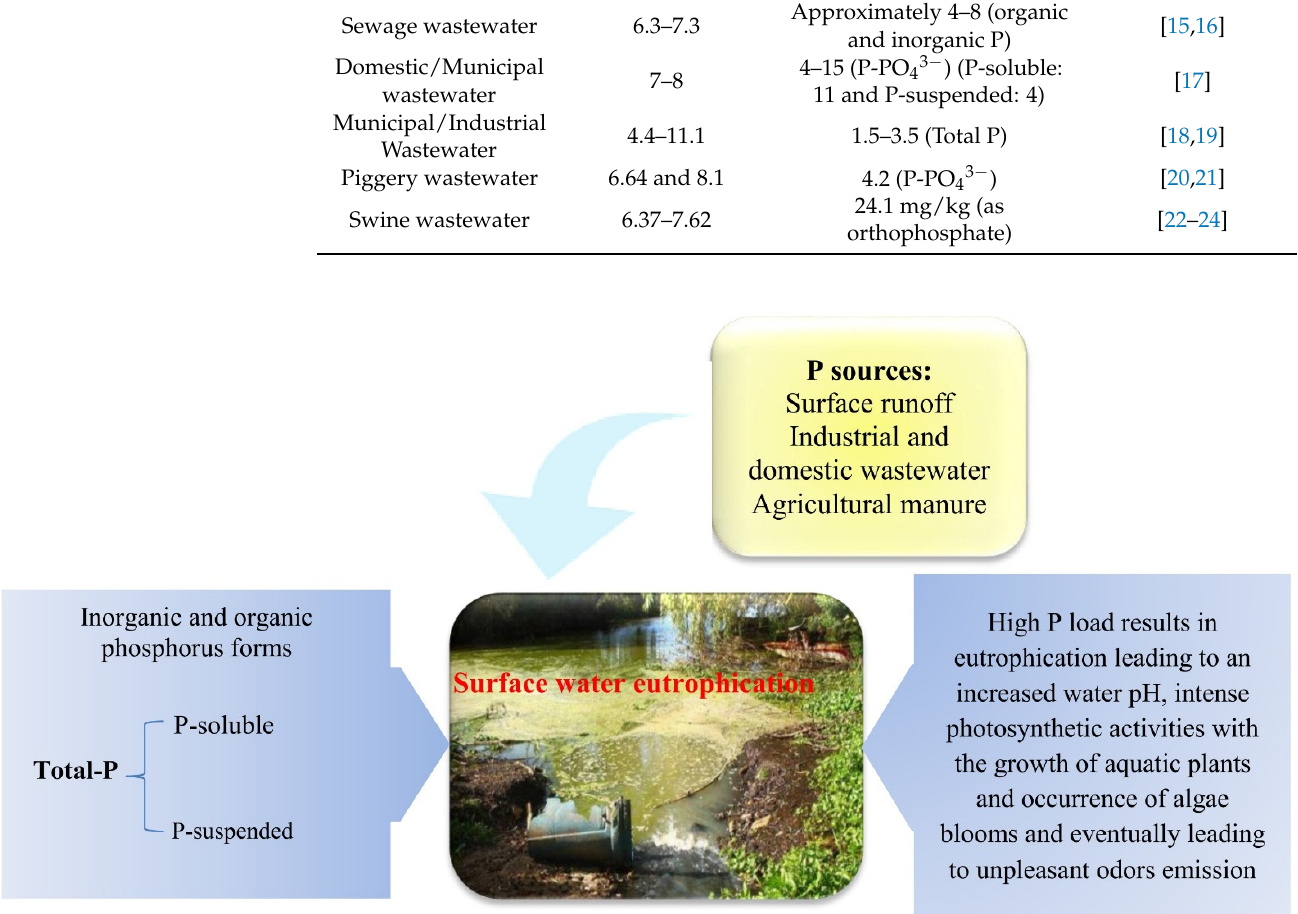
Figure 1. Different P sources to water resources and its consequences on water quality at high P concentration (free photograph from Nemery [13], Phosphorus and eutrophication, Encyclopedia of the Environment, [online ISSN 2555- 0950] url: https://www.encyclopedie-environnement.org/en/water/phosphorus-and-eutrophication/) (accessed on 07/02/2021). 7 February Table 1. Wastewater types with their pH and phosphorus concentration.